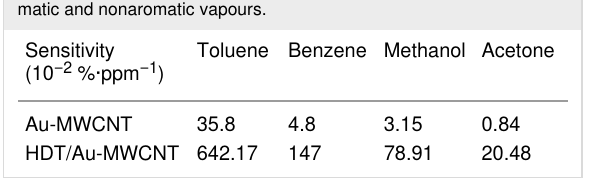
alkanethiol functionalised and decorated MWCNTs showed a high contact angle with water, which remains stable after a one month stay in aqueous media